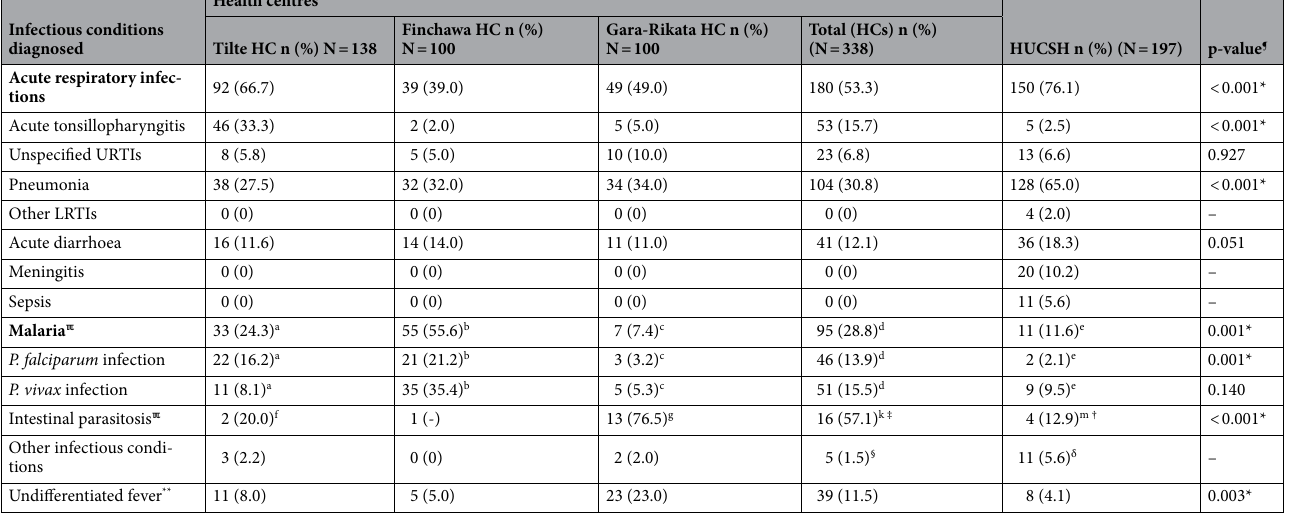
Table 3. Diagnosed infectious conditions in febrile children by study health facilities in Hawassa City, 2019. HC health centre, HUCSH Hawassa University Comprehensive Specialized Hospital, URTIs upper respiratory tract infections, LRTIs lower respiratory infections. ℼ Diagnosis made based on laboratory findings. Among children whose blood samples were examined by microscopy: a (N = 136); b (N = 99); c (N = 95); d (N = 330); e (N = 95). Among children whose stool samples were examined by microscopy: f (N = 10); g (N = 17); k (N = 28); m (N = 31). † Giardiasis (n = 1), ascariasis (n = 2), isosporiasis (n = 1). ‡ Giardiasis (n = 3), ascariasis (n = 12), trichuriasis (n = 1). δ Acute otitis media (n = 1), eye infection (n = 2), hospital acquired infection (n = 1), measles (n = 2), viral hepatitis (n = 1), pyomyositis/cellulitis (n = 4). § Acute otitis media (n = 2), bacterial conjunctivitis (n = 1), urinary tract infection (n = 2). ** Cases without identified source of infection for the fever on clinical and/or laboratory investigations conducted. ¶ Comparison of proportions between all health centres and HUCSH. *Significant difference (p-value < 0.05 from chi-square